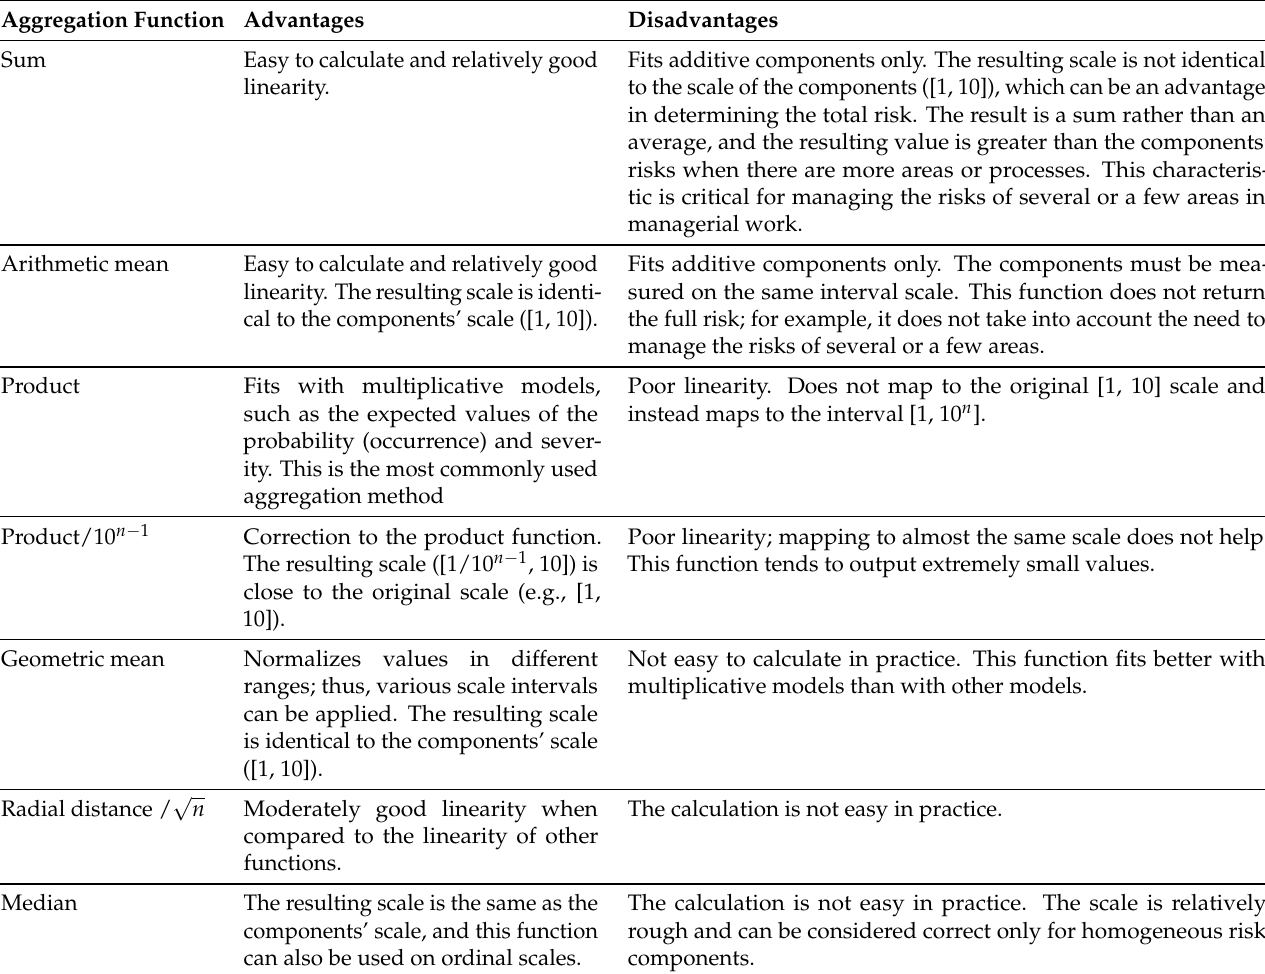
Table 2. Characterization of risk aggregation